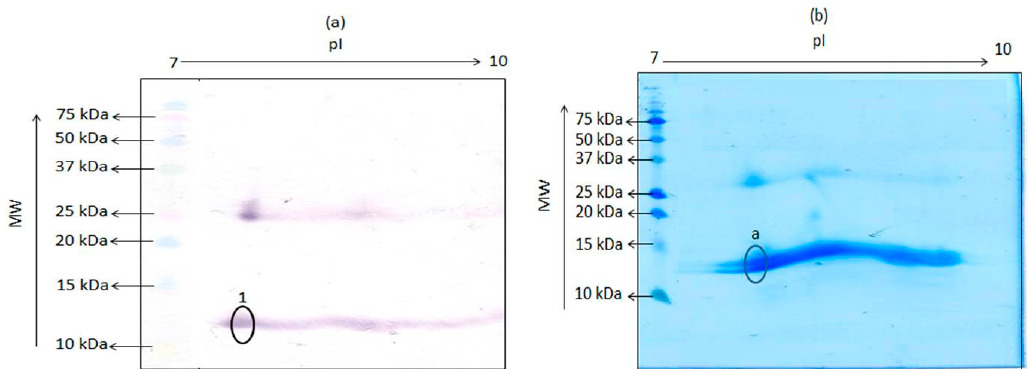
Figure 2. Two-dimensional gel electrophoresis of porcine hemoglobin extract containing 25 μ g total protein followed by transfer unto ( a ) nitrocellulose membrane and detection with mAb 24C12-E7 and ( b ) PVDF membrane and subsequent staining with EZBlueTM. Precision Plus Protein Kaleidoscope pre-stained standards were run alongside for estimation of molecular weight of proteins. Circled spot “a” on the PVDF membrane was subjected to N -terminal sequencing. Table 1. N -terminal sequence data for the excised spot labeled “a” on PVDF (polyvinylidene fluoride). Sequence